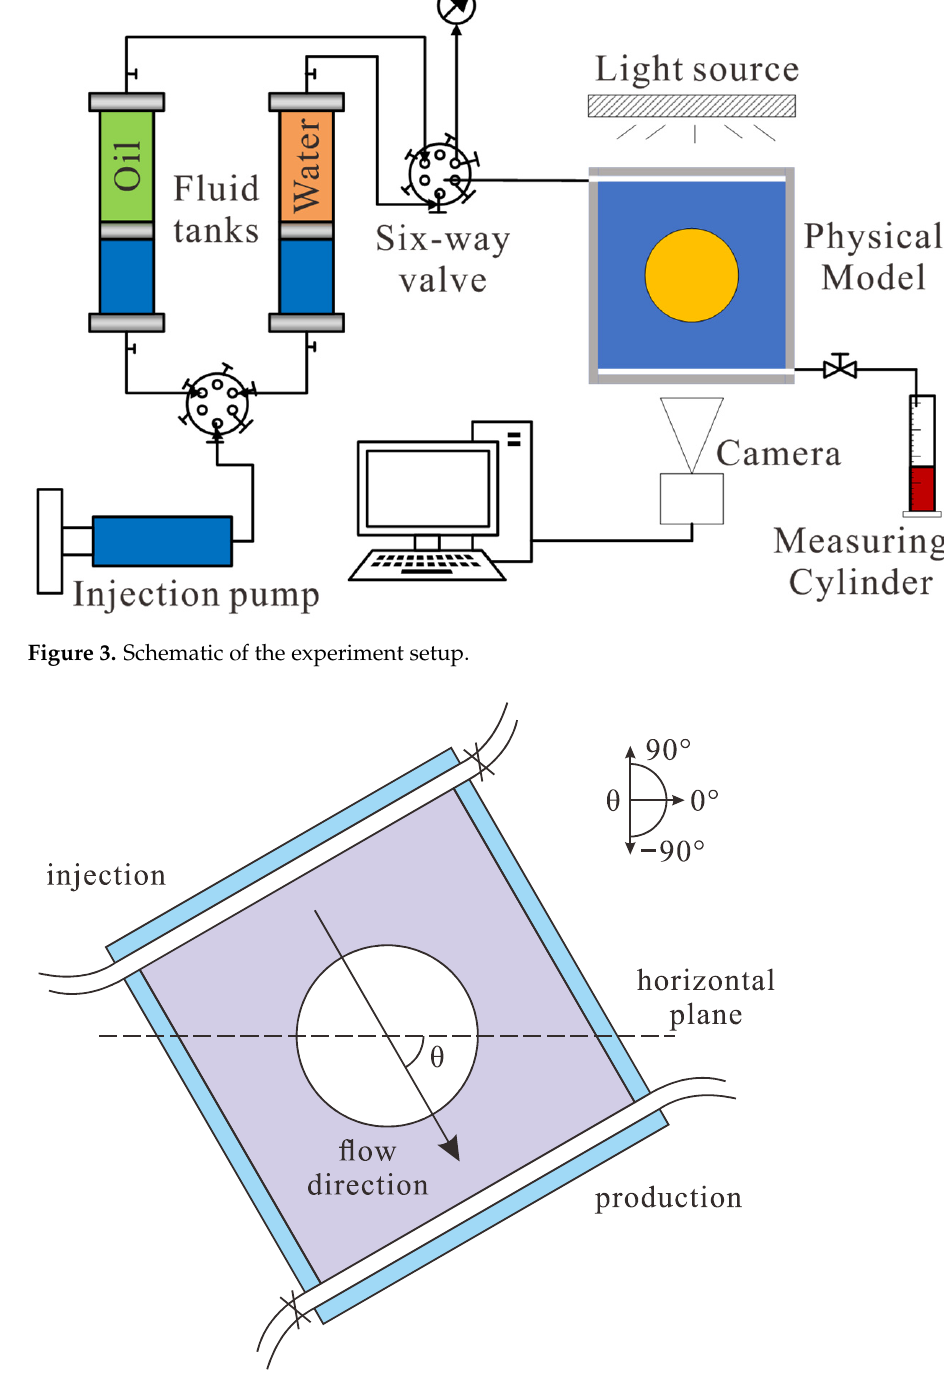
Figure 4. Definition of the angle θ in this study. The angle is taken between the flow direction in the single-vug model and the horizontal plane and has a range of [ − 90°, 90°].